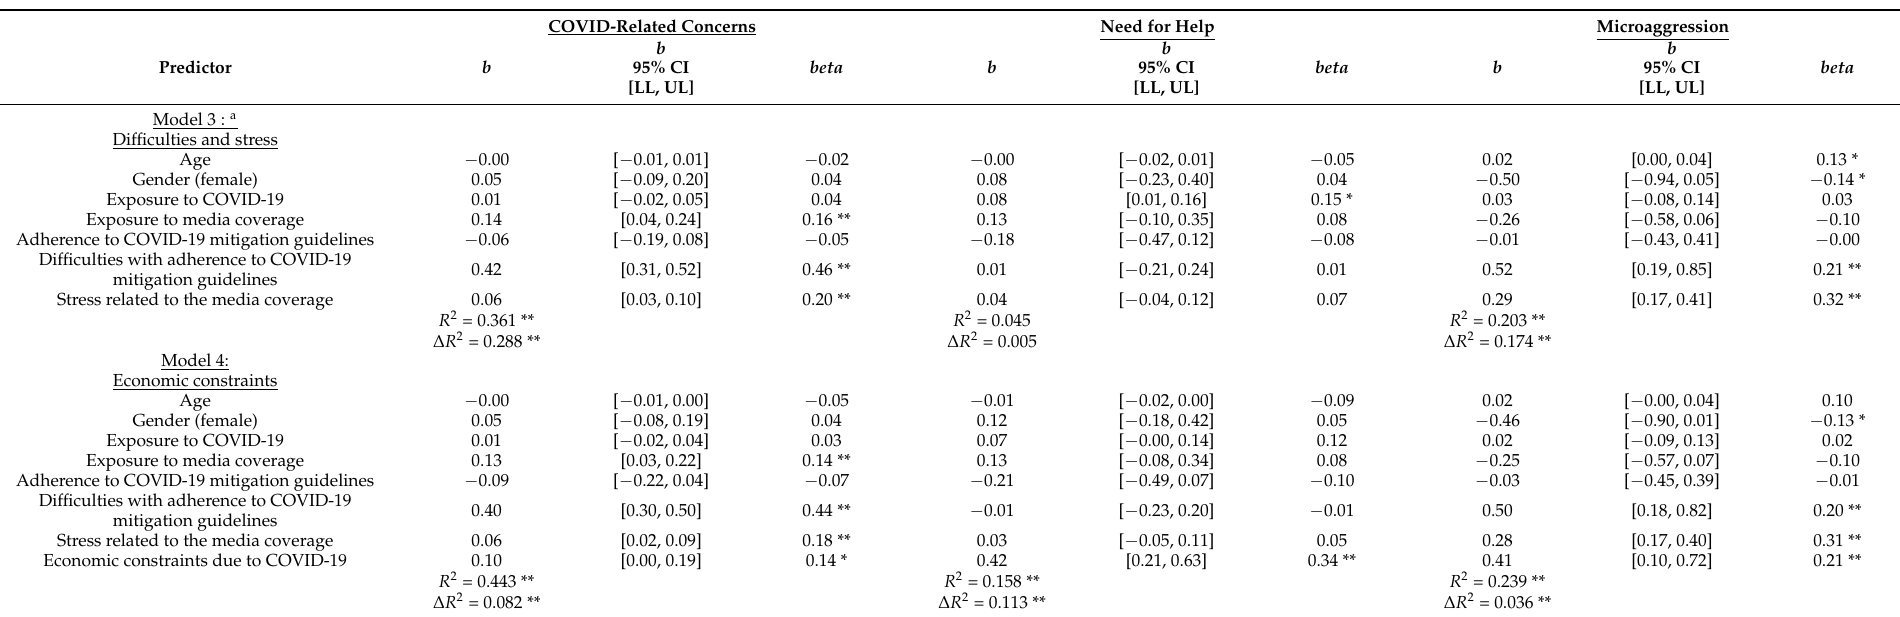
Table 3. Hierarchical regression analyses for predictors of psychological distress: COVID-related concerns, need for help, and microaggression among ultra-Orthodox Israelis. COVID-Related Concerns Need for Help Microaggression b beta Predictor b 95% CI [LL, UL] Model 3 : a Difficulties and